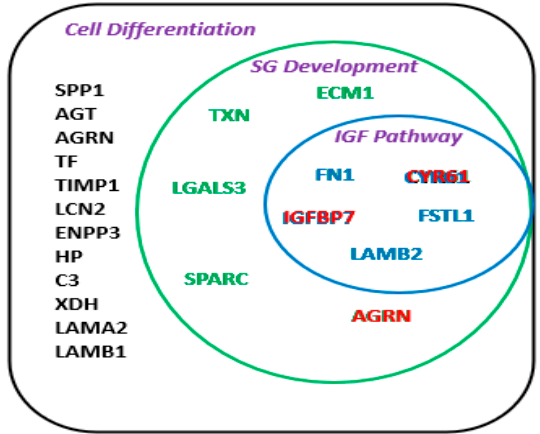
Figure 4. Secretory proteins involved in cell differentiation, which were identified in the conditioned media of mMSC-pSGC co-culture at day 1. The secretome contained 21 proteins that are known to play a role in cell differentiation. Of these 21 proteins, a group of ten secretory proteins was found to be expressed during mouse salivary gland (SG) development (green circle), five proteins belonged to the IGF pathway (blue circle), and three proteins contained a growth factor domain (red).